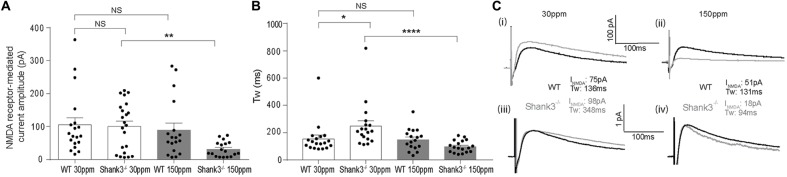
Increased dietary zinc specifically decreases cortico-striatal N-methyl-D-aspartate receptor (NMDA) receptor (NMDAR) mediated EPSCs in Shank3150 ppmex13−16−/− mice. (A)
Shank3ex13–16−/− deletion (Shank330 ppmex13−16−/−) had no effect on mean NMDAR mediated EPSC amplitude, but Shank3ex13–16−/− mice fed 150 ppm dietary zinc (Shank3150 ppmex13−16−/−) exhibited a decreased mean NMDAR EPSC amplitude (Kruskal-Wallis one-way ANOVA with Dunn’s post hoc test; WT30 ppm
n = 19 cells from 10 animals, Shank330 ppmex13−16−/−
n = 22 cells from nine animals, WT150 ppm
n = 18 cells from nine animals, Shank3150 ppmex13−16−/−
n = 18 cells from eight animals). (B) NMDAR decay kinetics, measured as the weighted time constant tau (τw), were significantly slowed in Shank330 ppmex13−16−/− mice. Increased dietary zinc in Shank3ex13–16−/− mice (Shank3150 ppmex13−16−/−) reversed the slowed kinetics (Kruskal-Wallis one-way ANOVA with Dunn’s post hoc test). (C) Example NMDAR EPSCs from both genotypes and dietary zinc levels. (i) NMDAR EPSCs from WT (black) and Shank3ex13–16−/− (gray) mice on 30 ppm diet. (ii) NMDAR EPSCs from WT (black) and Shank3ex13–16−/− (gray) mice on 150 ppm diet. (iii) Scaled NMDAR EPSCs from WT (black) and Shank3ex13–16−/− (gray) mice on 30 ppm diet. (iv) Scaled NMDAR EPSCs from WT (black) and Shank3ex13–16−/− (gray) mice on 150 ppm diet. All data represent mean ± SEM. *p < 0.05, **p < 0.01, ****p < 0.0001, NS, not significant.